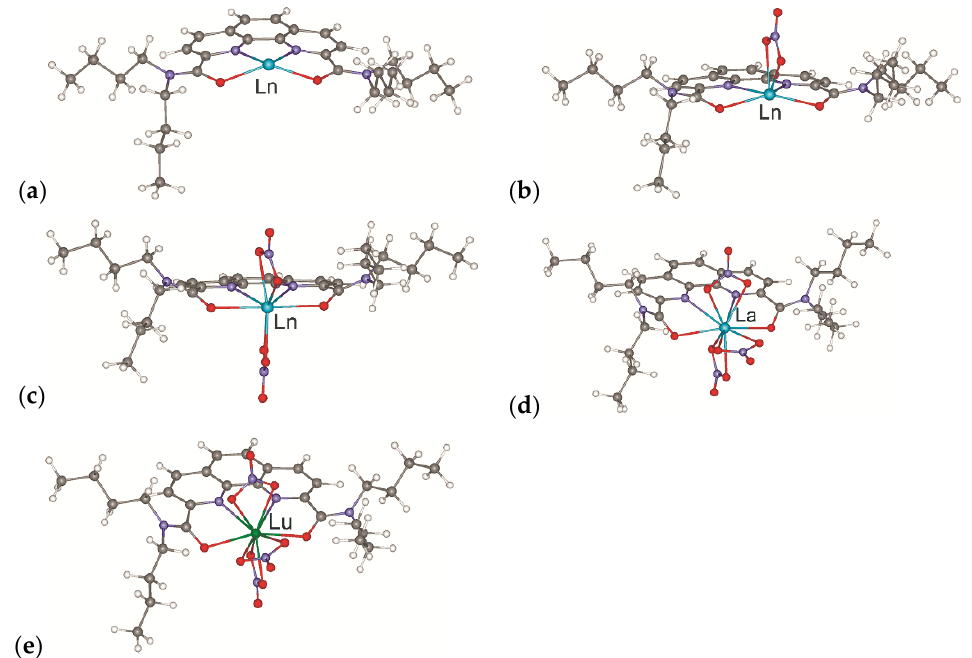
Figure 3. Structures of [ L2 Ln] 3+ ( a ), [ L2 Ln(NO 3 )] 2+ ( b ), and [ L2 Ln(NO 3 ) 2 ] + ( c ) cations (Ln = La–Lu); structures of L2 La(NO 3 ) 3 ( d ) and L2 Lu(NO 3 ) 3 ( e ) complexes according to calculation data. Changes in the binding energies ∆Е in the complexes of L2 are shown in Figure 4. The corresponding changes in bond lengths in the coordination node are given in Figure ∆Е rapidly increase with an increasing atomic number of the cation. The addition of the third anion to the [ L Ln(NO 3 ) 2 ] + cation, which leads to the formation of the neutral complex